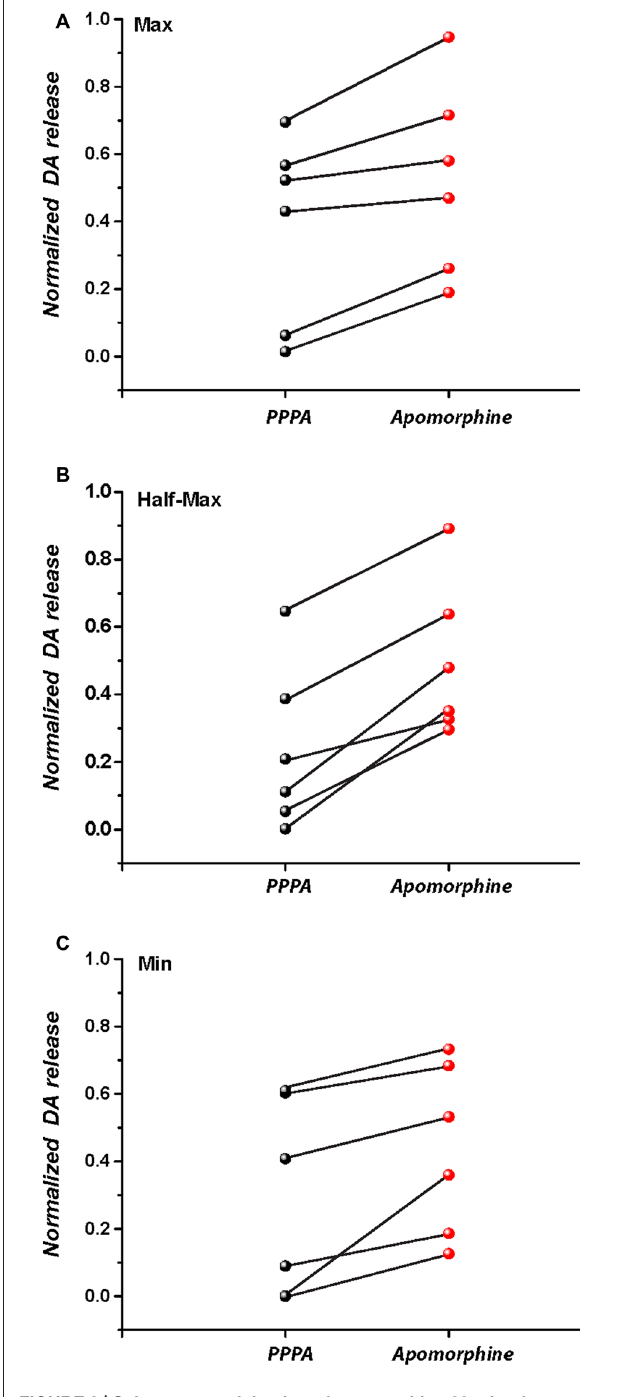
FIGURE 8 | Subcutaneous injection of apomorphine 20 min after intra-VM injection of PPPA partially restores stimulation-induced DA release at the maximal stimulation frequency (A), M50 stimulation frequency (B), and at the lowest stimulation frequency